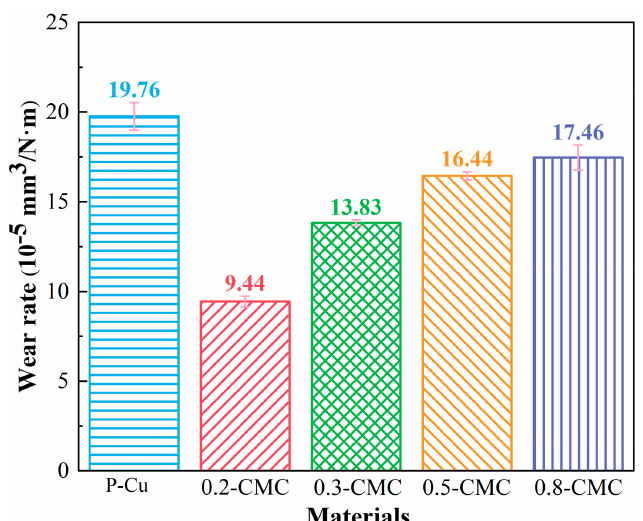
Figure 9. Wear rates of CMCs with different BNNSs volume